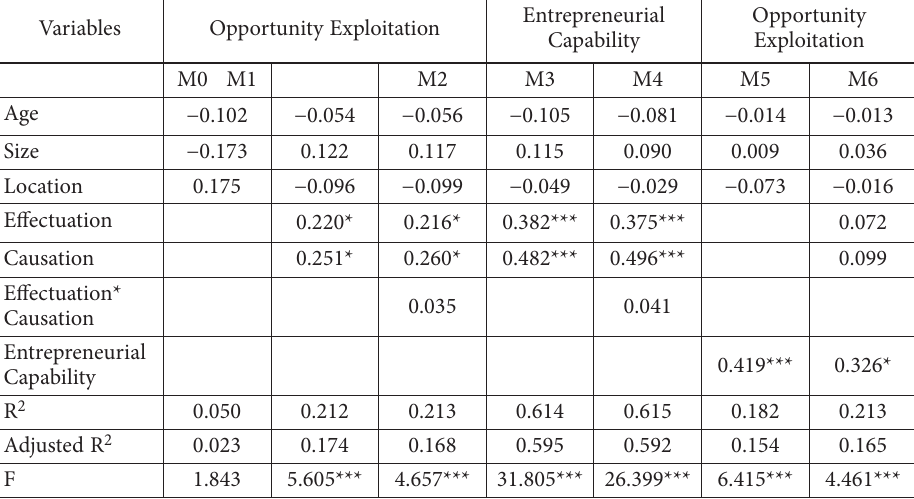
Table 5. Multivariate linear regression of the relationship between knowledge integration method, opportunity exploitation and high-tech new venture performance Entrepreneurial Variables Opportunity Exploitation